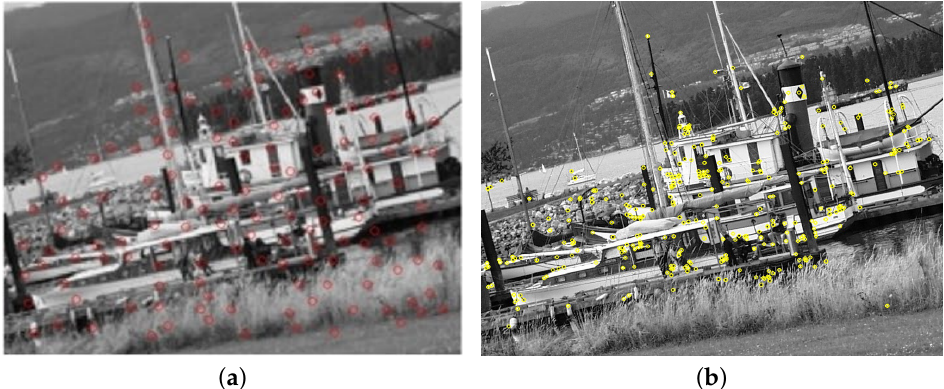
Figure 16. The extraction result of feature points of the image to be registered. ( a ) The adaptive RKEM algorithm; ( b ) The algorithm in this paper.